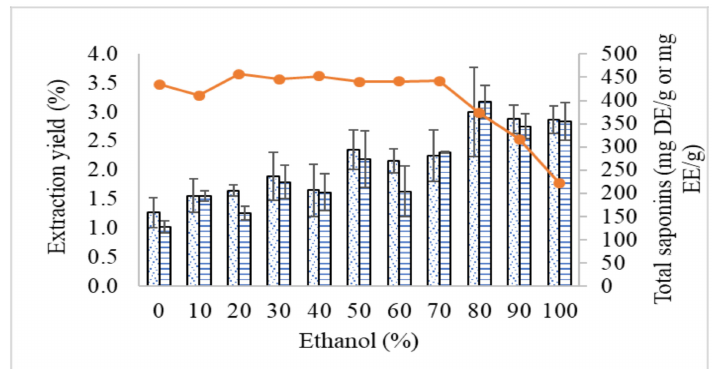
Figure 1. Yield of extraction (line) and total saponins using diosgenin (dot bar) and escin (line bar) as standard chemicals.